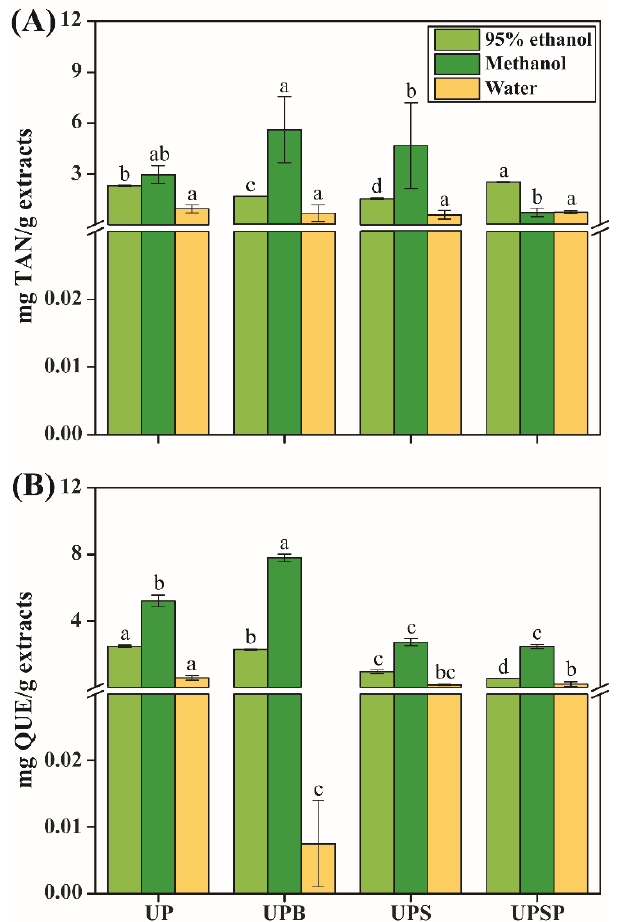
Figure 1. Total polyphenol ( A ) and flavonoid ( B ) content of different parts of Undaria pinnatifida . UP: whole U. pinnatifida, UPB: U. pinnatifida blade, UPS: U. pinnatifida stipe, UPSP: U. pinnatifida sporophylls. TAN: tannic acid, QUE: quercetin. The different letters (a–d) indicate a significant difference ( p < 0.05).